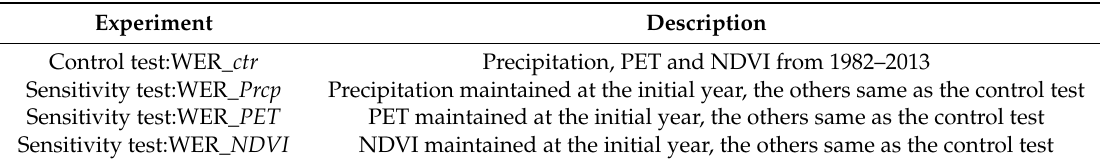
Table 2. Numerical experiment design for WER